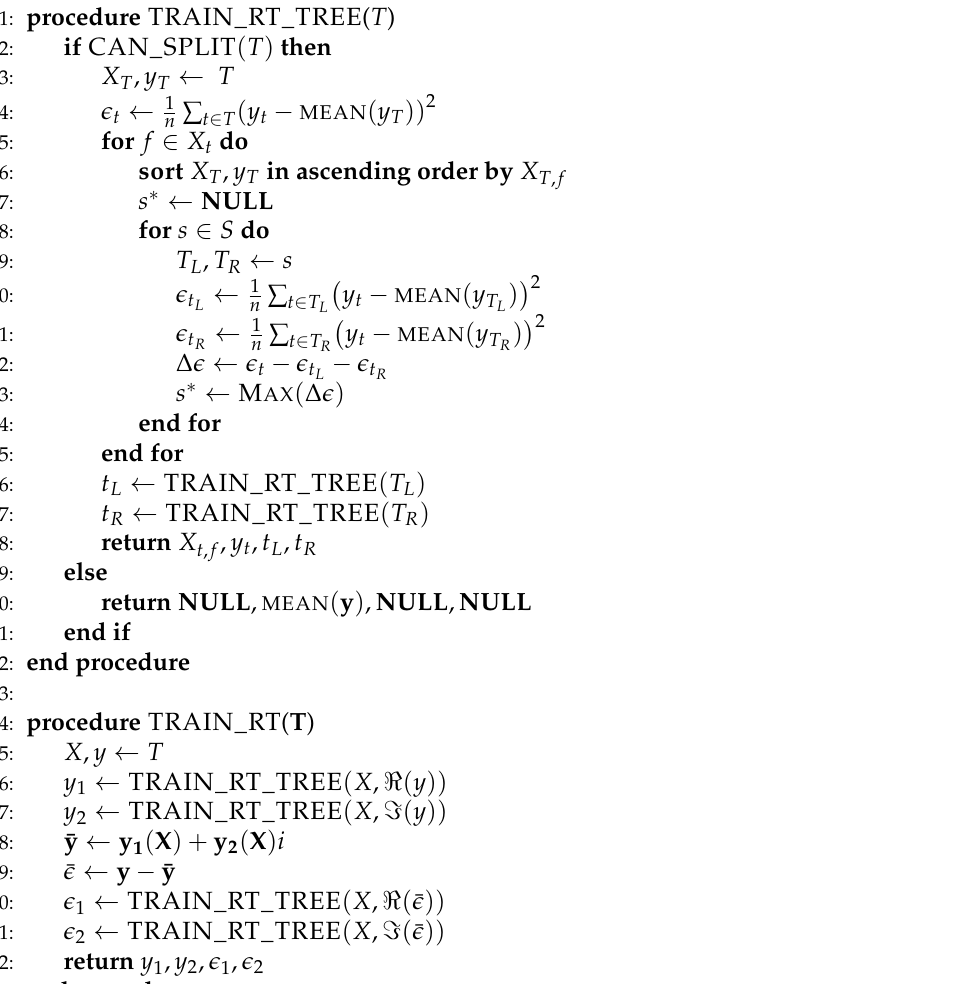
Algorithm 1 Training procedure for Regression